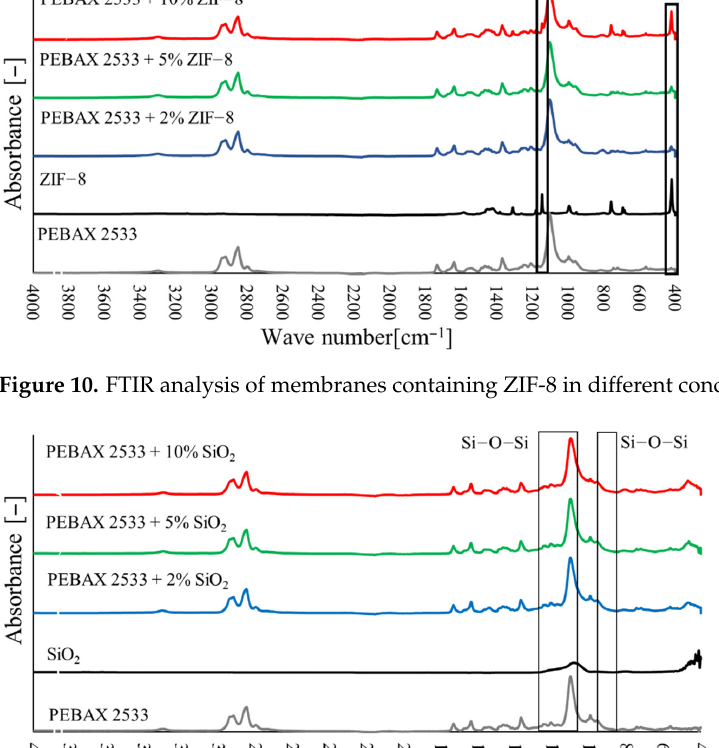
Figure 12. FTIR analysis of membranes containing POSS-Ph in different concentrations. 3.3. Differential Scanning Calorimetry (DSC), Thermogravimetric Analysis (TGA) and Process Parameters (P, D, S, α ) The results of the DSC and TGA tests cannot be interpreted without a direct reference to the test results of the process parameters of the analyzed membranes. Some of results are presented below (Figures 13–15 and Tables 1–9) and some of additional results are presented in Appendix A (Figures A1–A3 and Tables A1–A12). In Tables 1–3, the following symbols are used: T m —melting temperature; H m —melting enthalpy; X c —crystallinity; PE—polyether group (amorphous phase); PA—polyamide group (crystalline phase). The thermograms can be found in Appendix Figures A1–A3. Table 1. DSC analysis results for membranes containing ZIF-8. Parameter